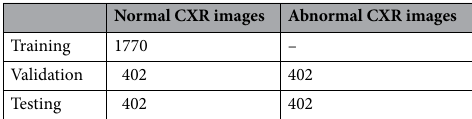
Table 1. Dataset details.